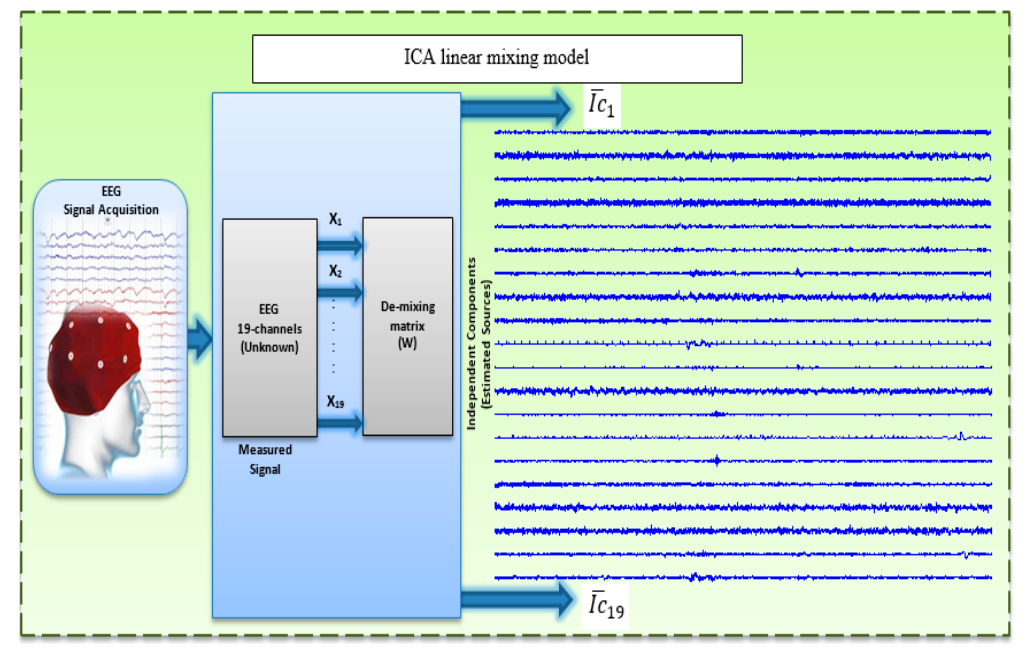
Figure 3. Linear mixing model.